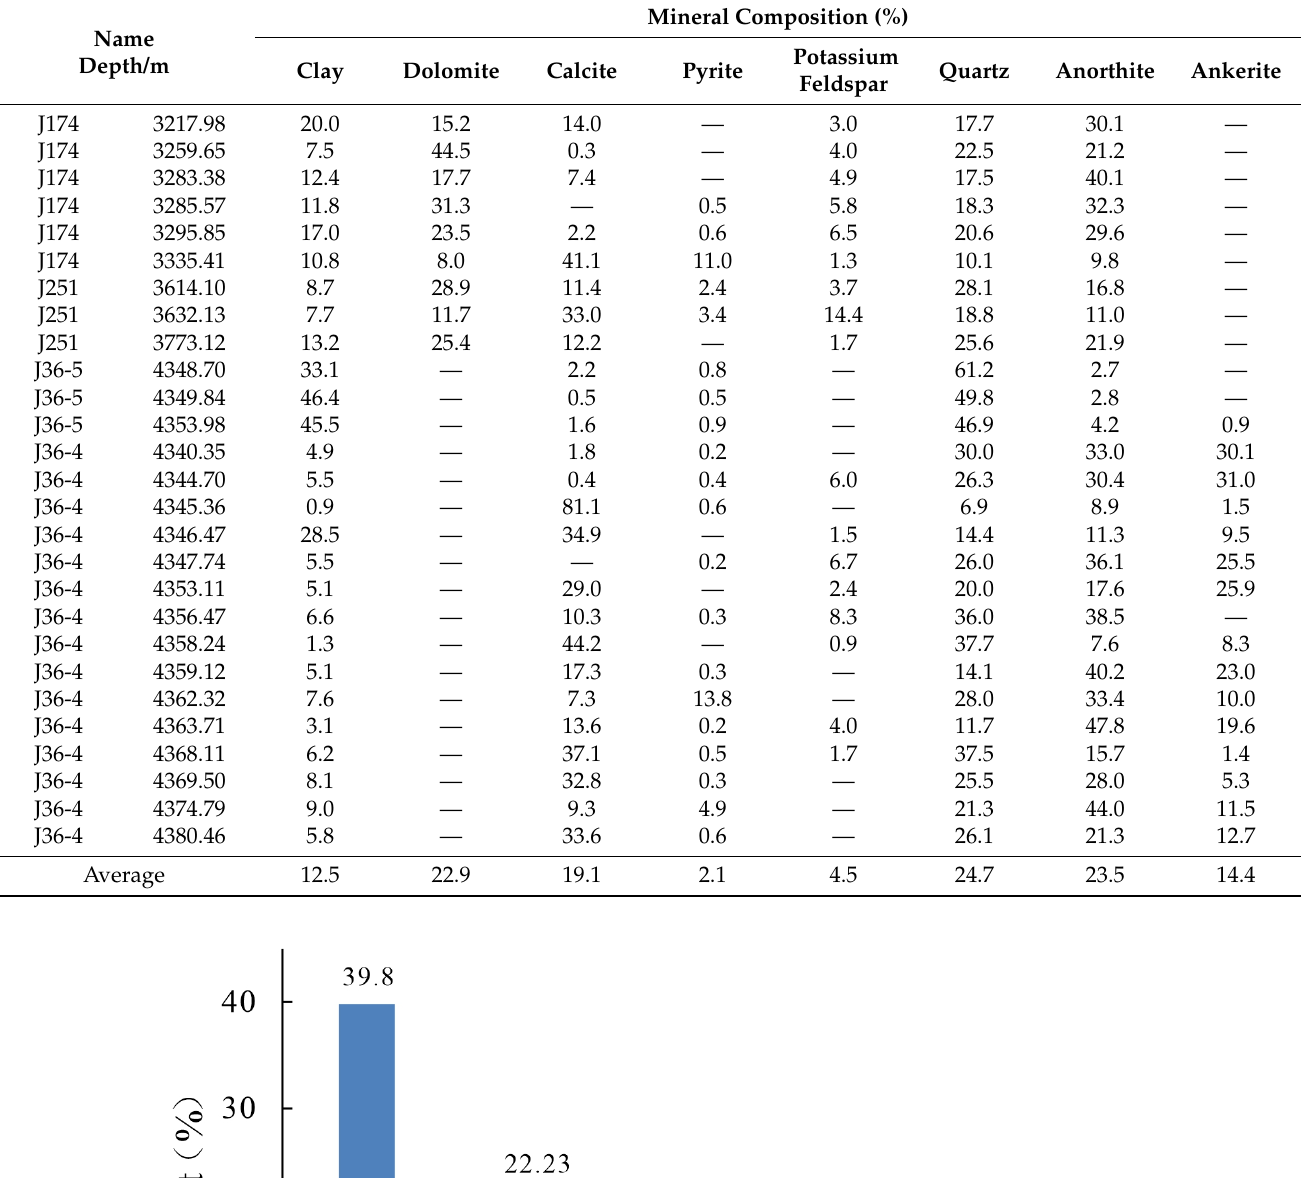
Table 1. XRD analysis of reservoir rocks in the Lucaogou Formation of Jimsar Sag.